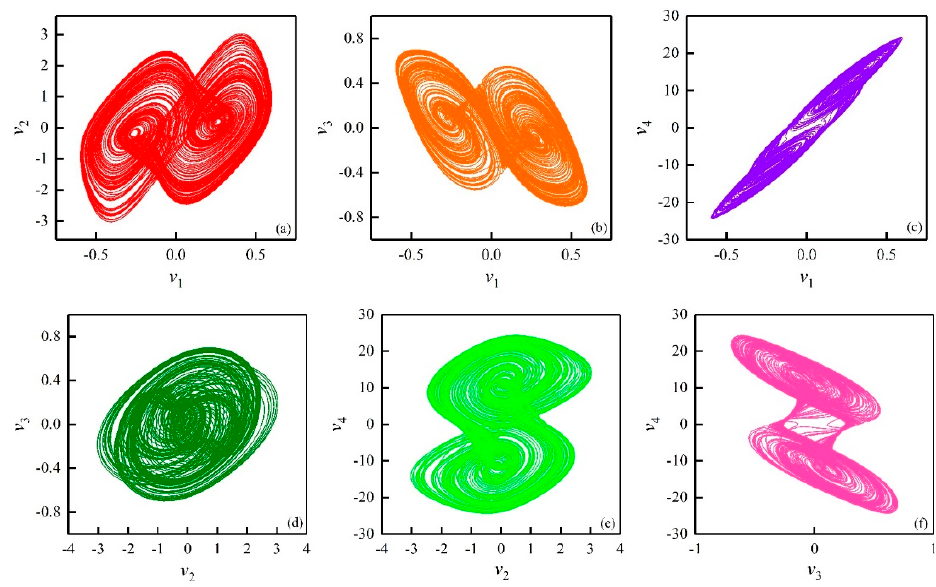
Figure 2. The phase diagram of the chaotic attractor ( a – f ) with q = 0.55, β 1 = 0.72, β 2 = 12.5. ( a ) v 1 - v 2 plane; ( b ) v 1 -v 3 plane; ( c ) v 1 -v 4 plane; ( d ) v 2 - v 3 plane; ( e ) v 2 -v 4 plane; ( f ) v 3 -v 4